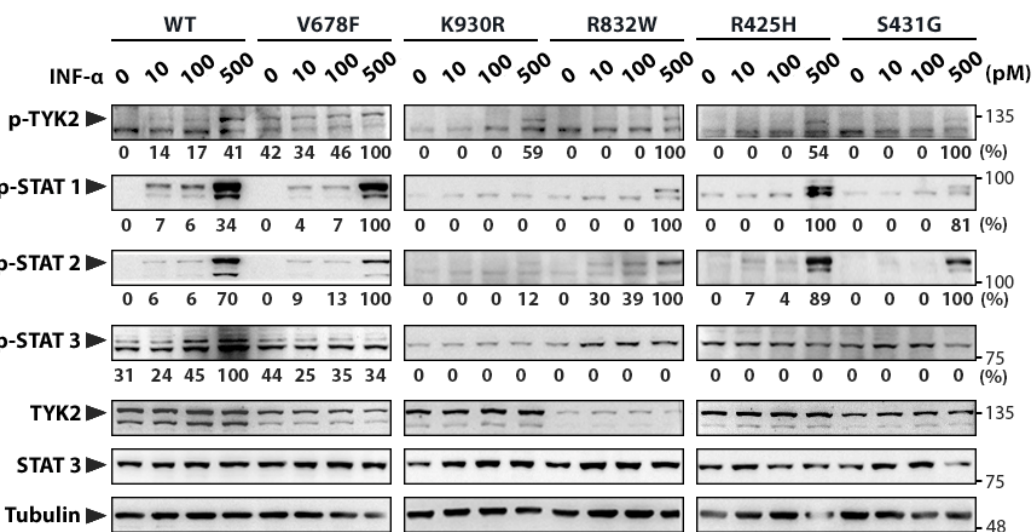
Figure 2. Functional analyses of TYK2 variants. Human TYK2-deficient U1A cell line was transfected with the different TYK2 variants and clones stably expressing these variants were selected. Clones were stimulated with the indicated doses of IFN α for 15 min, and the level of phosphorylation of TYK2 variants and STAT1–3 transcription factors was assessed by Western blot. Arrowheads point out the size of specific proteins and molecular weight markers (kDa) are noted on the right. Quantification of phosphorylated proteins is relative to TYK2 total protein (to account for TYK2 expression differences among cell lines) and then to Tubulin (shown under each lane / membrane). Values are expressed as percentage of the highest value of each membrane. WT: wild-type TYK2; V678F: catalytically